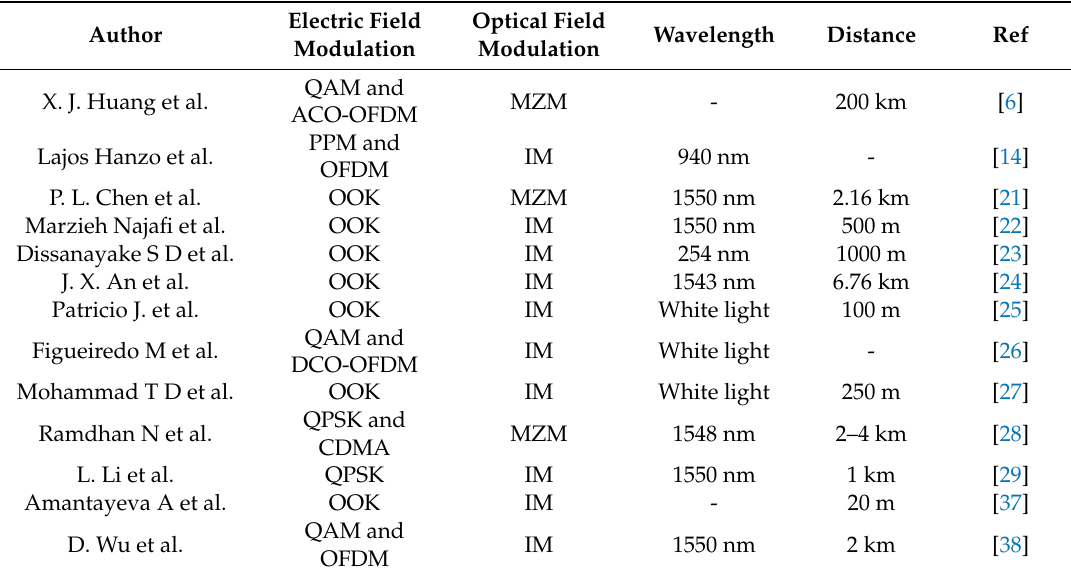
Table 1. The types of UAV optical wireless